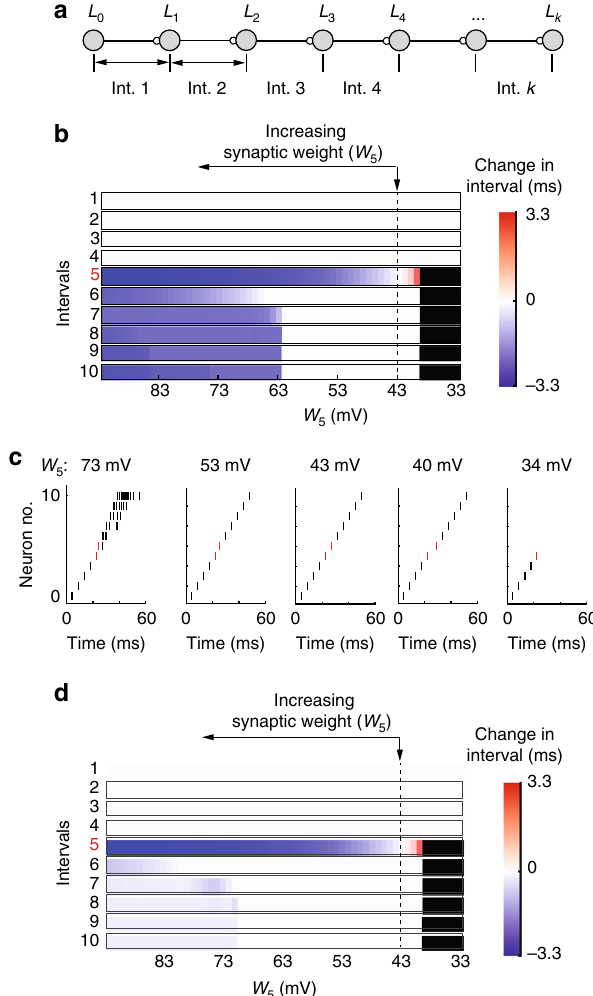
Fig. 4 Flexible timing with chains of single neurons. a Schematic showing the network architecture. b A chain of 11 integrate and fi re neurons was simulated with the fi rst spike time of each neuron marking an interval boundary. W 5 (the weight between node 4 and 5) was varied, which corresponds to changes to the gradient vector for the fi fth interval (Methods). Changes with respect to baseline interval durations, which were 4.6 ms, are shown. Black denotes chain propagation breakdown. Vertical arrow shows the baseline network con fi guration with each neuron spiking once. c Example runs of a chain of integrate and fi re neurons. Only one neuron per layer is shown. d Same as b , except neurons have a 1